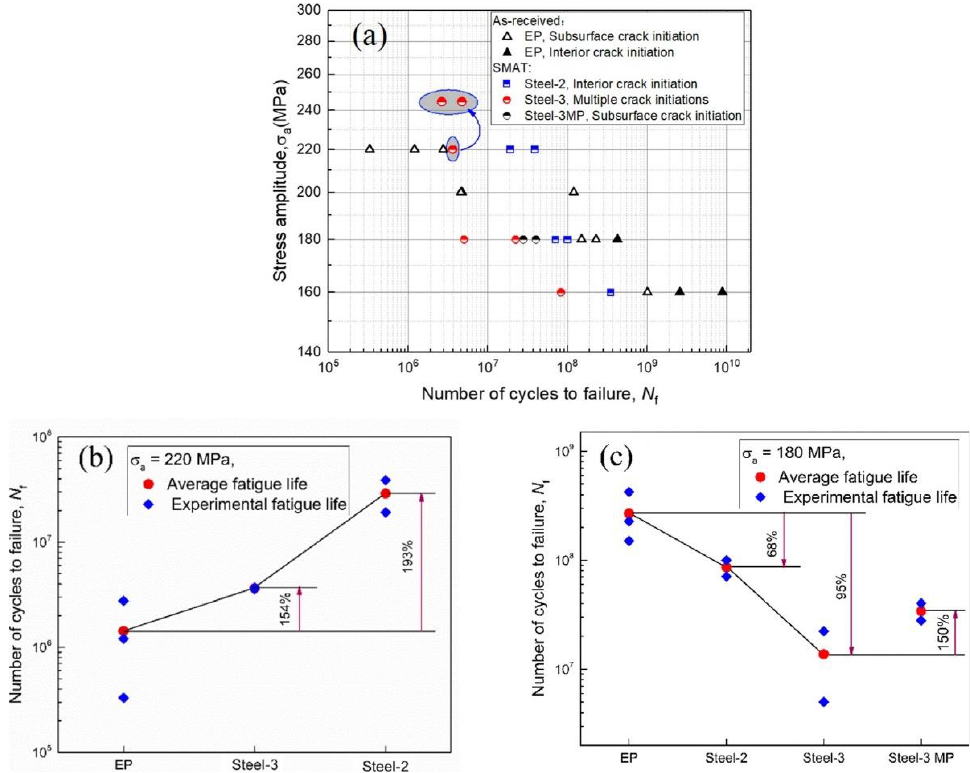
Figure 7. ( a ) S-N plot of the uniaxial ultrasonic fatigue test results of 7075-T6 aluminum specimens in as-received (EP) condition and after Steel-2, Steel-3, and Steel-3MP SMAT treatments. ( b ) Comparison of average fatigue lives at σ a = 220 MPa. ( c ) Comparison of average fatigue lives at σ a = 180 MPa. Reprinted with permission from Ref. [5]. Copyright 2020 Elsevier. Table 3 Comparison of treatments, surface roughness, and maximum compressive residual stress of 7075-T6 aluminum specimens in as-received (EP) condition and after Steel-2, Steel-3, and Steel- 3MP SMAT treatments [5].